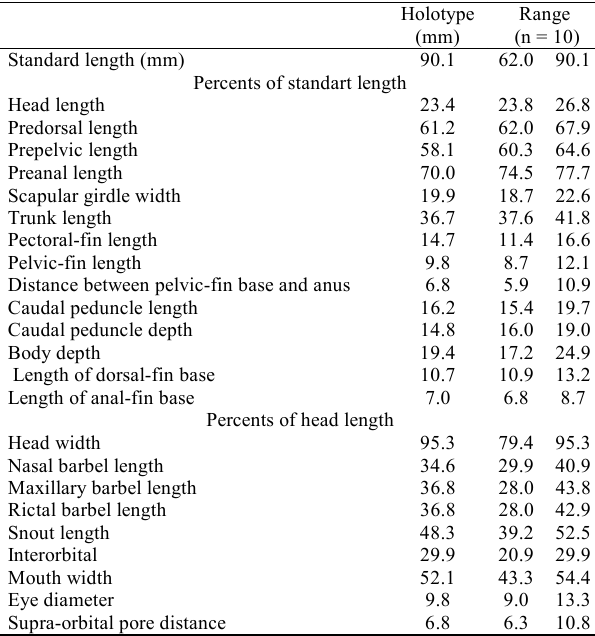
Table 1. Morphometric data for holotype and paratypes (ex- cept MPEG 13354) of Trichomycterus igobi (n = 10 including the